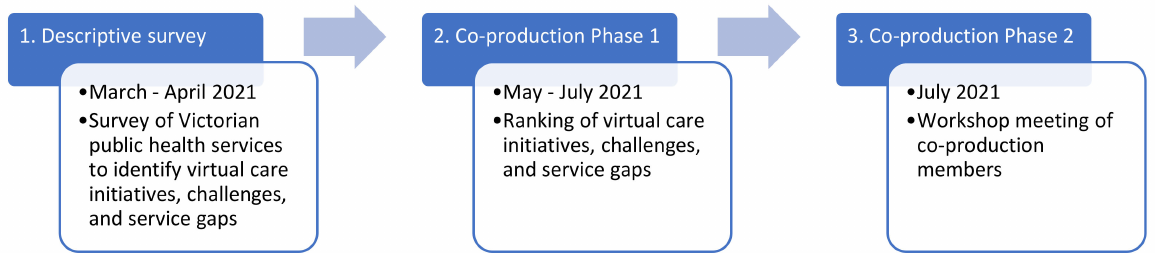
Figure 1. Research activity